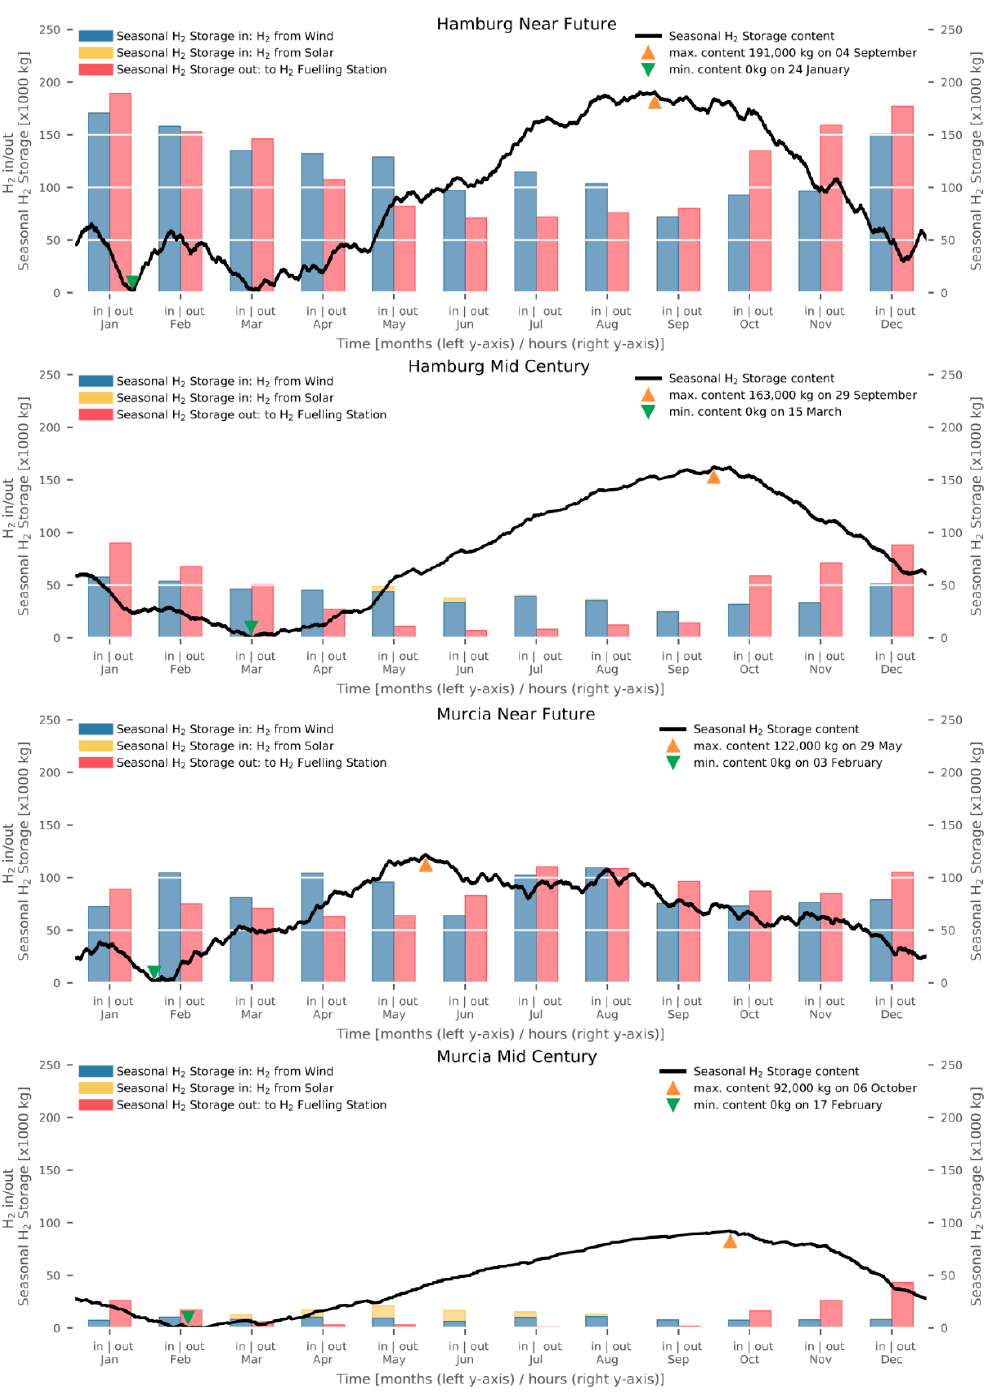
Figure A3. Seasonal hydrogen storage content over the year (black line), from top to bottom Hamburg Near Future and Mid Century and Murcia Near Future and Mid Century. The annual maximum and minimum are indicated by an upward (orange) and downward (green) facing triangle. For every month, the bars on the left side (in) represent the monthly inflow of hydrogen from either solar (yellow) or wind (blue), and the bar on the right (out) shows the monthly outflow to the hydrogen fueling station.